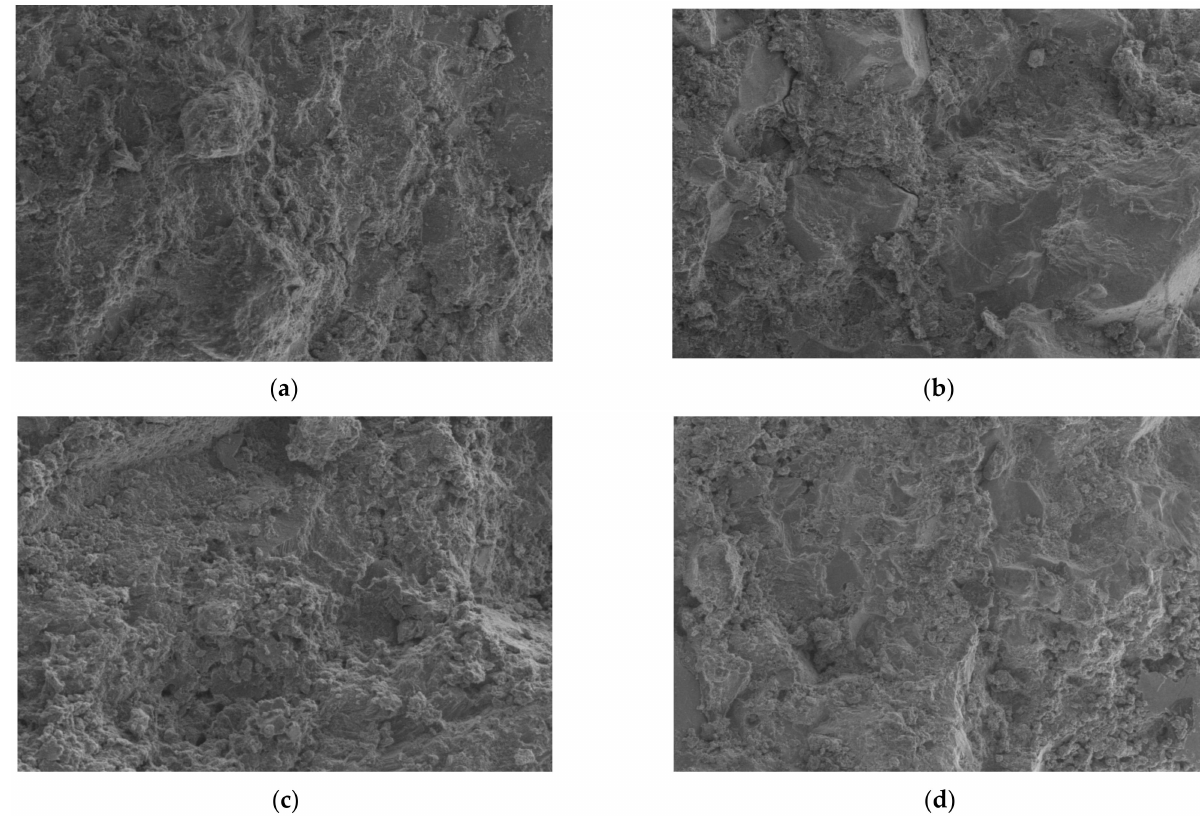
Figure 11. SEM. ( a ) Reference composite, ( b ) NM1 composite, ( c ) NM2 composite, ( d ) NM3